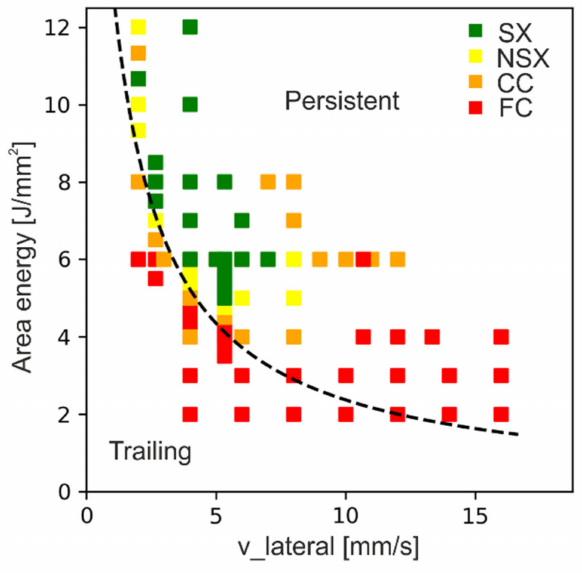
Figure 10. Experimental microstructure data from Figure 7( a ) and calculated separation line from Figure 9 between trailing melt pool and persistent melt pool.